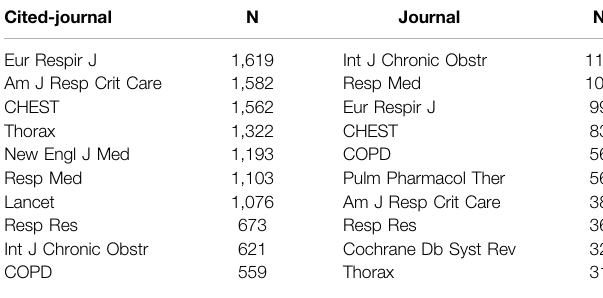
TABLE 3 | The list of top 10 cited journals that published COPD drugs-related studies from 1980 to